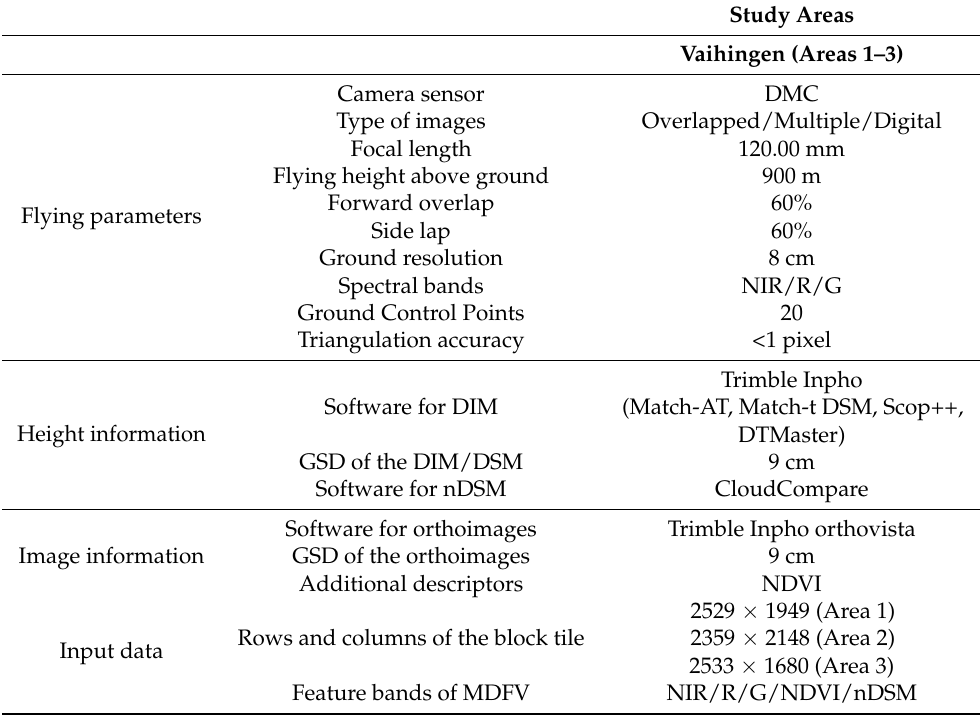
Table 1. Flight parameters and used